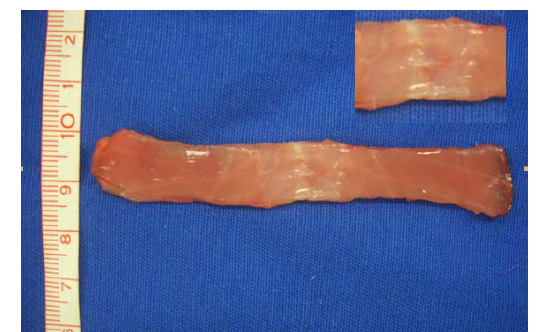
FIGURE 1 – Tissue sample of the anterior abdominal wall with 1cm thickness. The area to